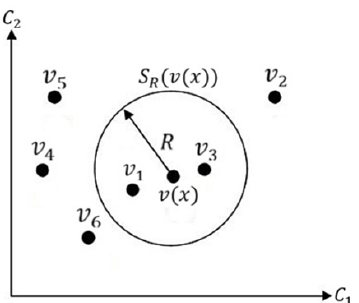
Figure 6. Pixel classification using a circular area S R ( v ( x )) in a two-dimensional Euclidean color space ( C 1 , C 2 )